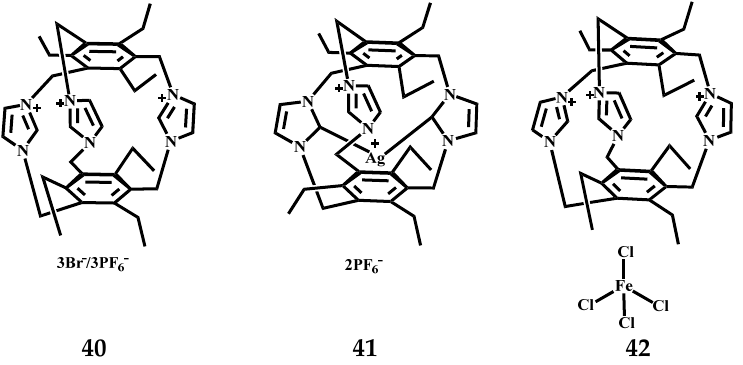
Figure 19. The structures of tris(imidazolium) cyclophane 40 and its two organic-inorganic supramolecular hybrids.